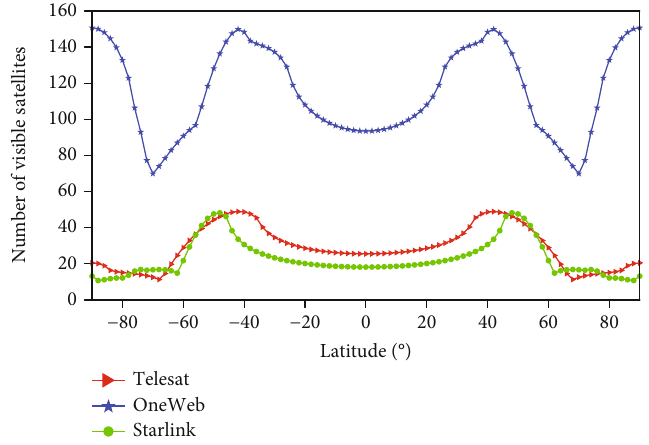
Figure 4: The number of visible satellites in a typical constellation (25 ° elevation angle).